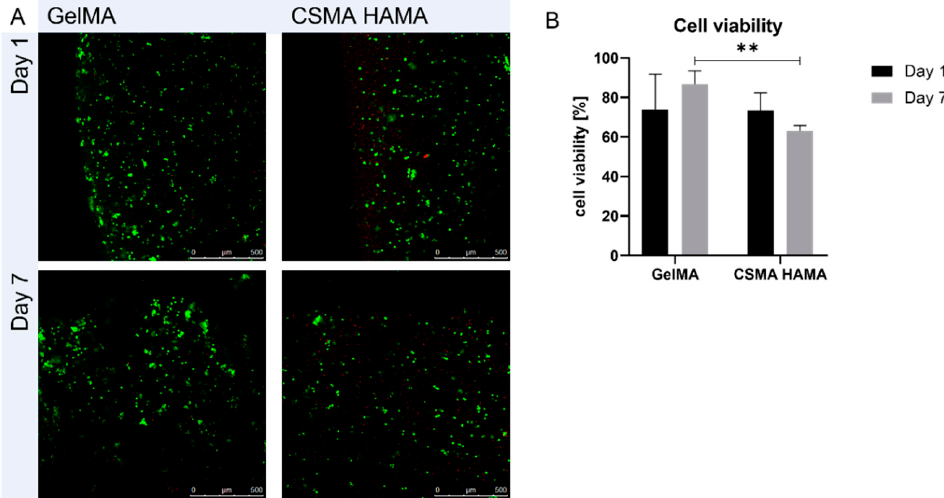
Figure 5. ( A ) Cell viability of gelatin–methacrylamide (GelMA) and CSMA/HAMA HydroSpacers after 1 and 7 days of culture. Viable cells are stained in green, dead cells in red. ( B ) Percentage of living cells embedded in the GelMA and CSMA/HAMA HydroSpacers ( n = 5). The significance is indicated with **, with double signs referring to a p ‐ value < 0.01.